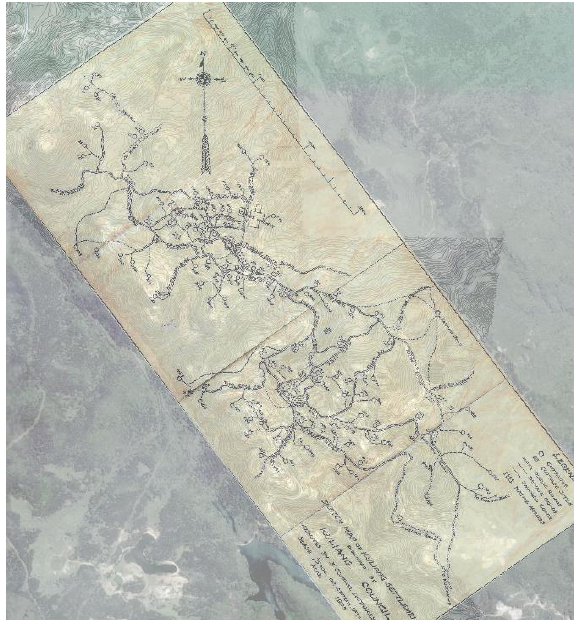
Figure 1 The rectified 1919 historical map, overlaid with the 2018 orthophoto map and 2019 topographic